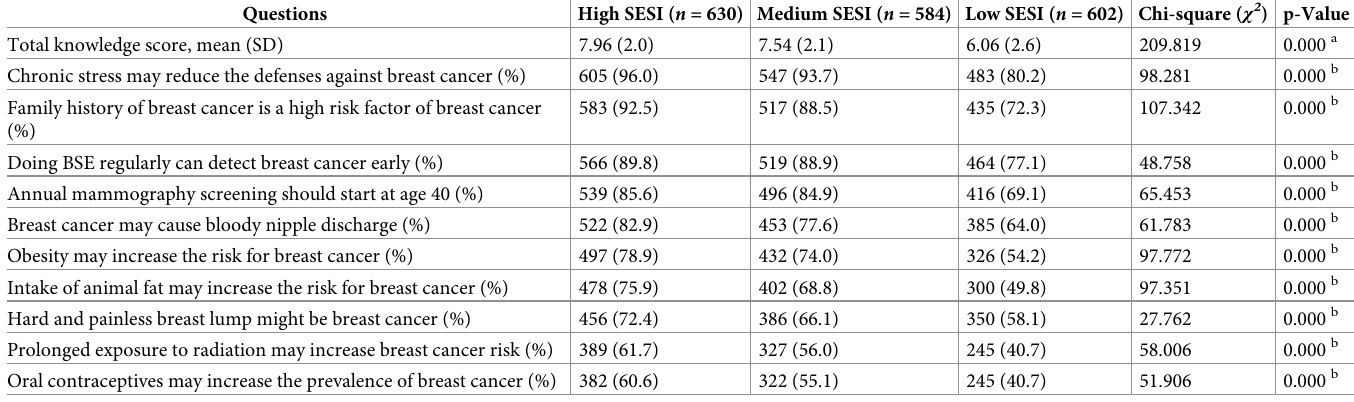
Table 2. Comparison of breast cancer knowledge among women with different SESI (n = 1816).